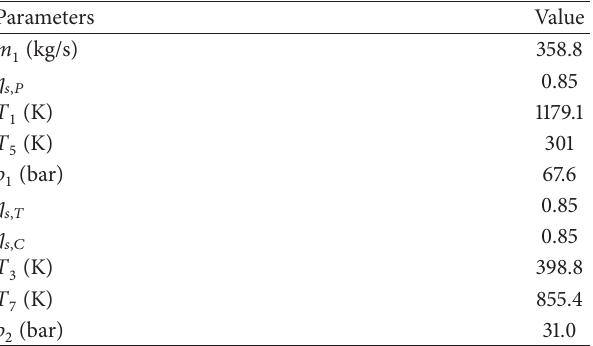
Table 5: Specifications of the combined cycle [19].